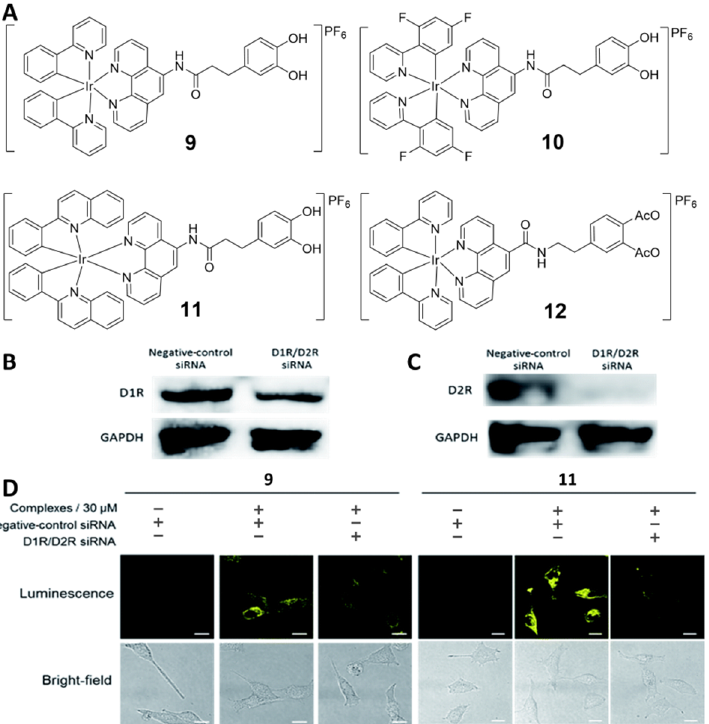
Figure 8. ( A ) Chemical structures of complexes 9 − 12 . The relative amount of D1R/D2R in A549 cells before ( B ) or after ( C ) D1R/D2R siRNA treatment. ( D ) Cell images of A549 cells with complexes 9 and 11 in D1R/D2R knockdown experiment. A549 cells were incubated with or without complexes 9 and 11 (30 μM) for 1 h. Reproduced with permission from ref. [65]. Copyright 2018 Royal Society of Chemistry.